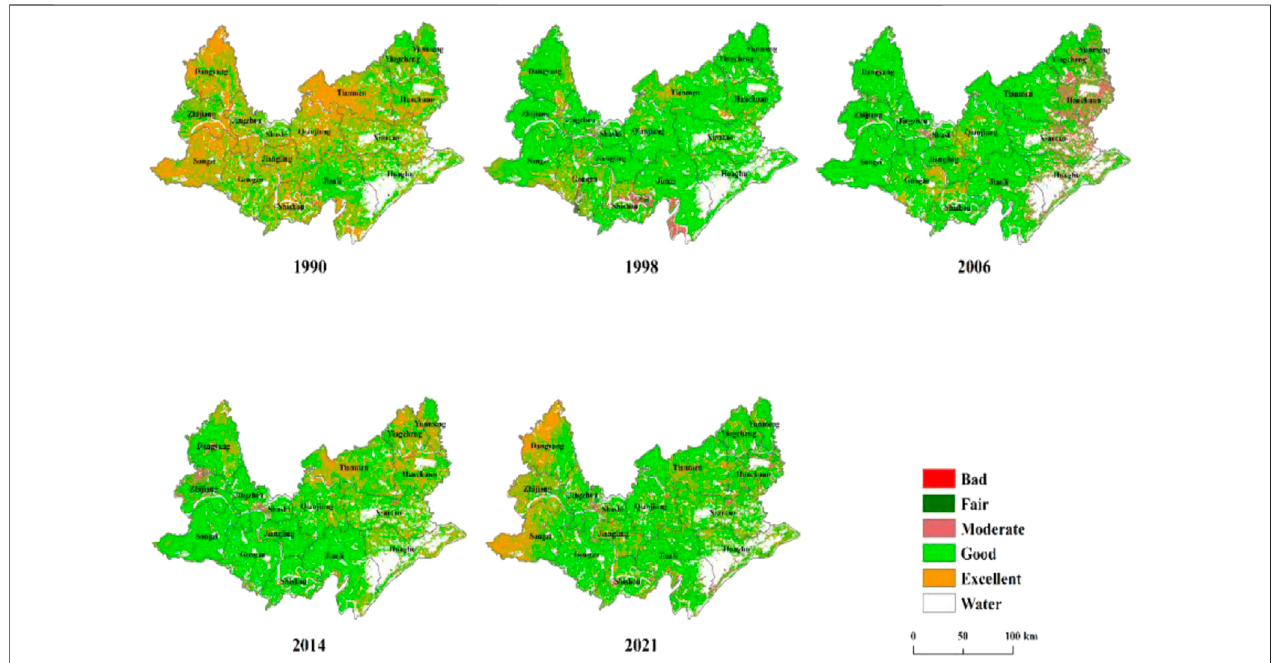
FIGURE 4 | Spatial distribution of ecological environmental quality on Jianghan Plain from 1990 to 2021.